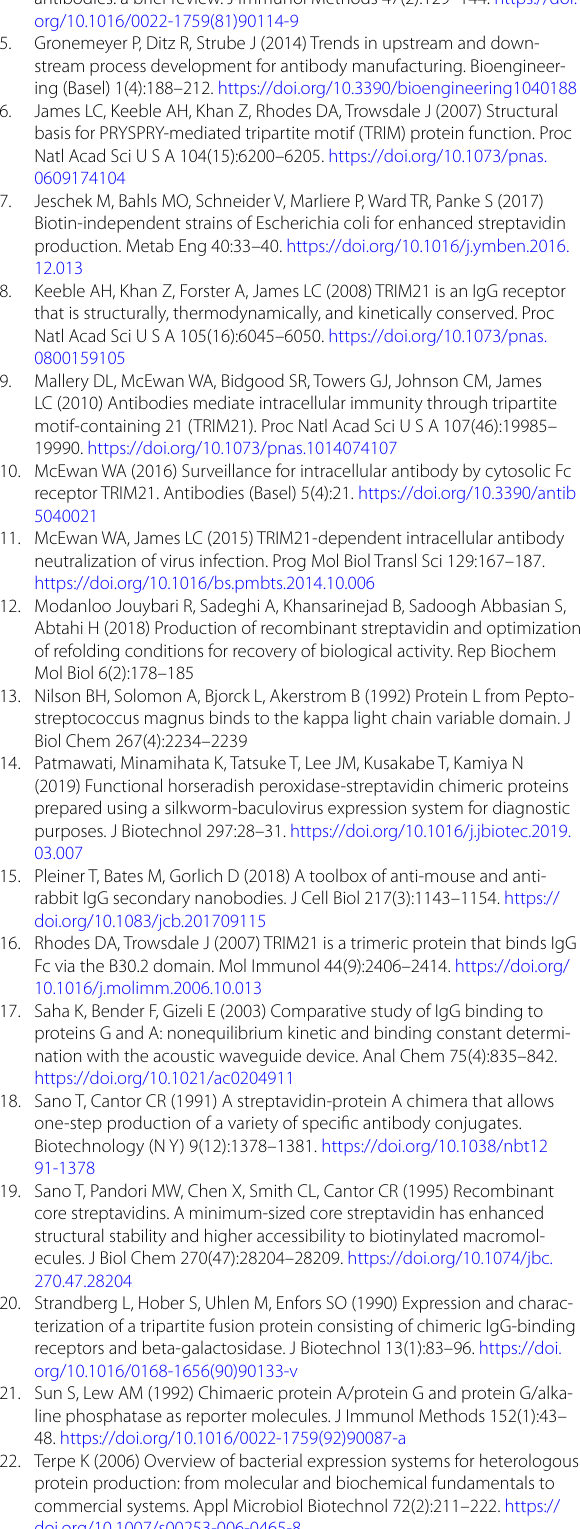
Additional file 3: Figure S3. Comparison with protein A and G coupled to HRP from two different vendors using serum from numerous